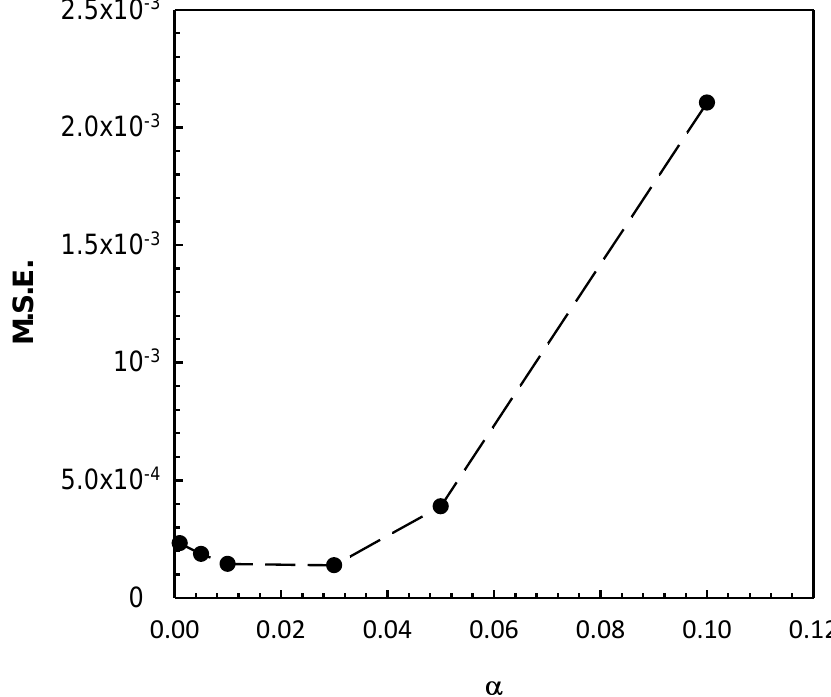
Figure 10. Mean squared error (MSE) between simulation and experimental results of Figure 9.